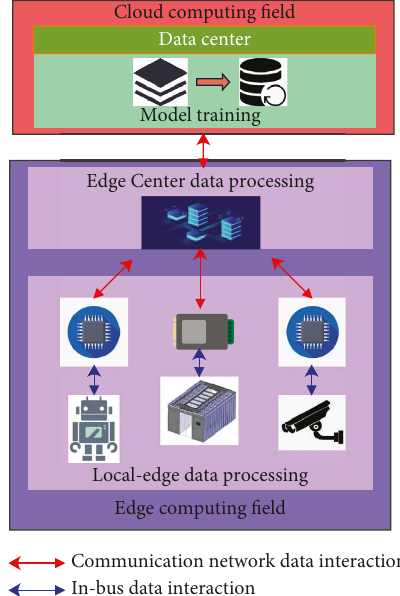
Figure 4: Schematic diagram of the process of edge computing in the industrial Internet application